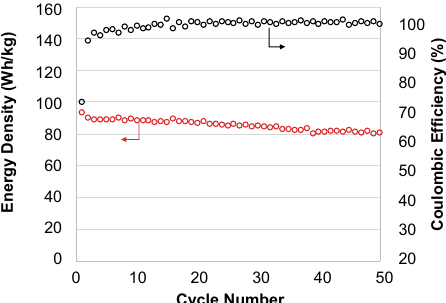
Fig. 6 Structural ceramic battery (SCB) full cell cycling test at a C/5 rate. The initially low coulombic ef fi ciency is due to prelithiation (methods). Energy density and coulombic ef fi ciency indicate stable electrochemical performance over 50